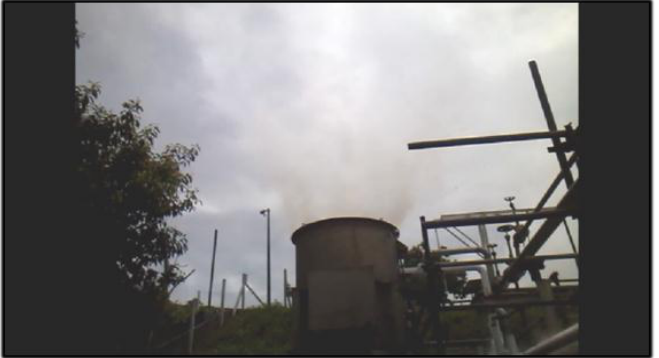
Figura 2. Vaporizador.